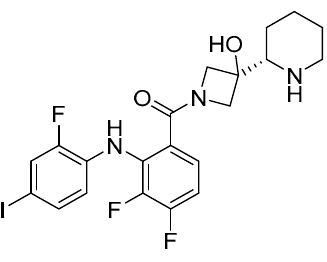
Figure 2. Chemical formula of cobimetinib.